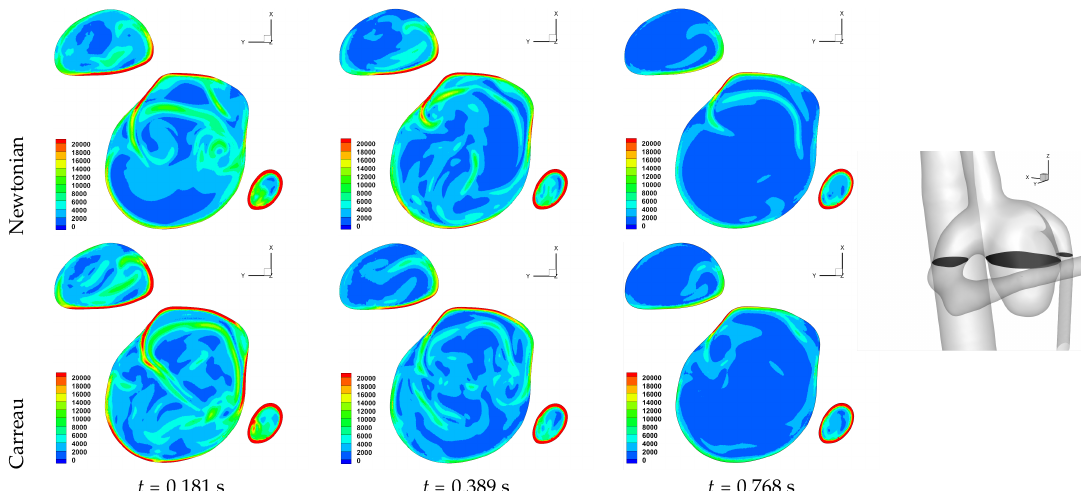
Figure 11. Cross-section plots of shear rate magnitude ˙ γ (s − 1 ) of Case 6, for Newtonian and Carreau rheological models. Location of the cross-section is